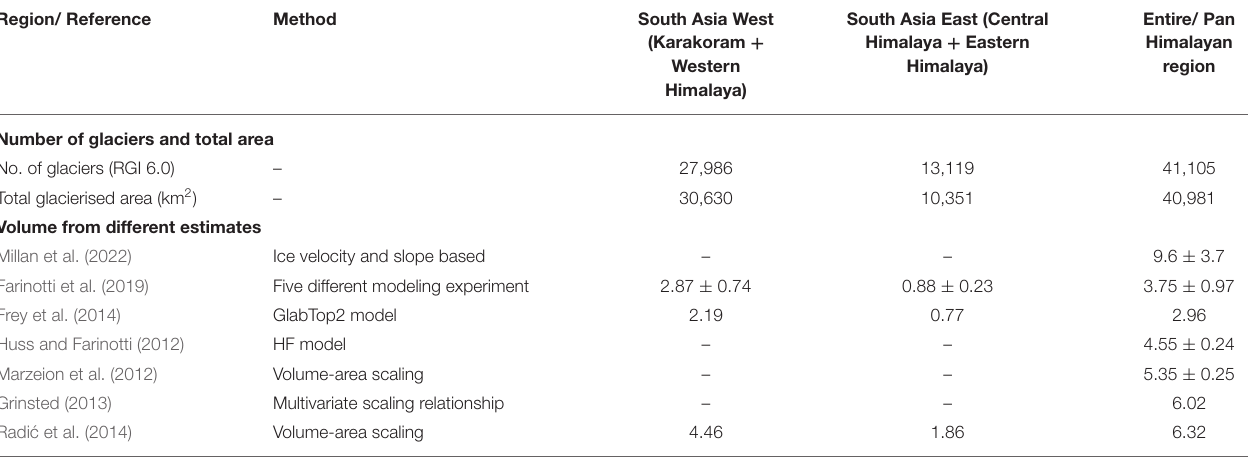
TABLE 5 | Summary of estimated ice volume (10 3 km 3 ) in the Himalayan region. Region/ Reference